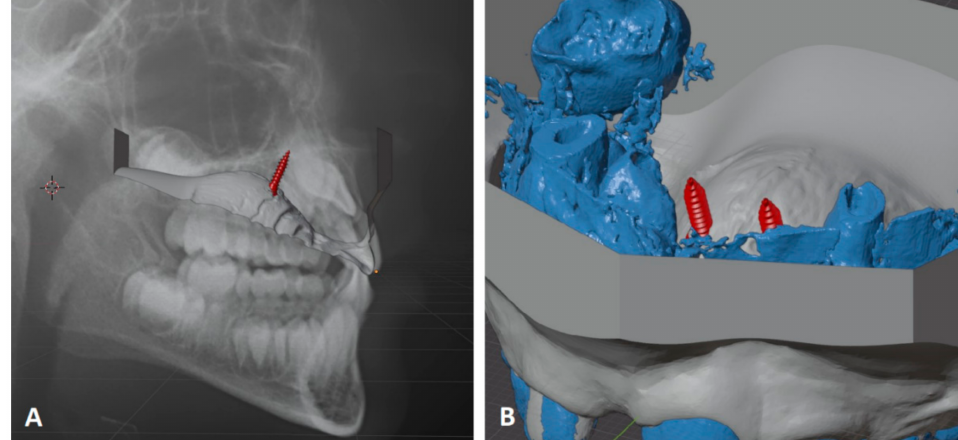
Figure 4. ( A ) Superimposed lateral ceph radiograph for the planning of implant placement. ( B ) CBCT can aid implant placement planning in more complex cases (software: Blender, Blender